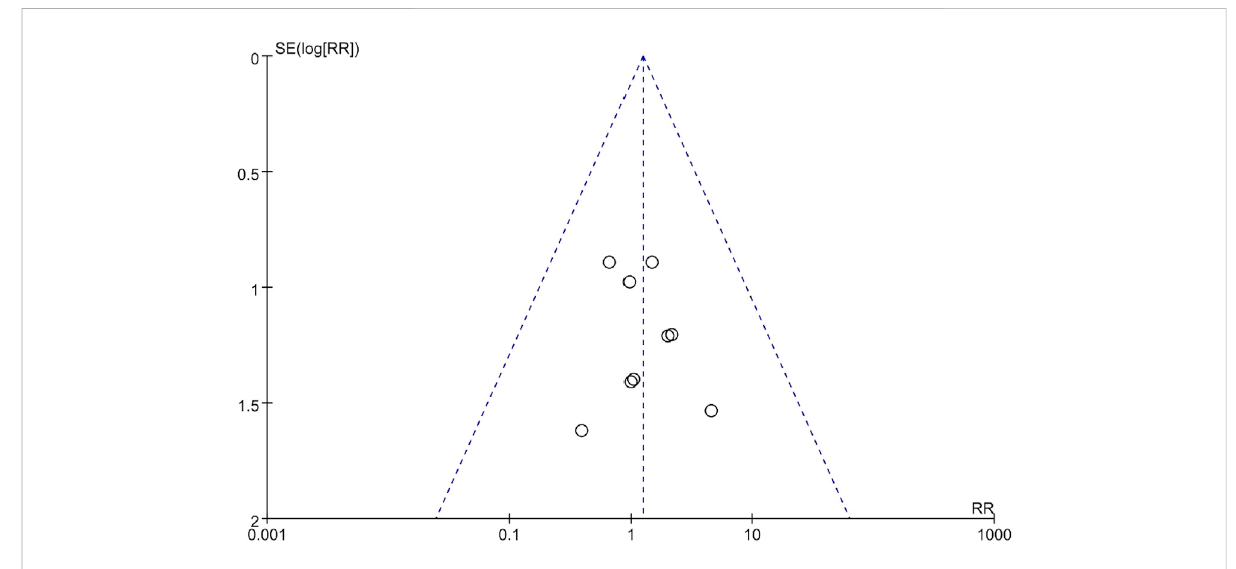
FIGURE 9 Funnel plot of the incidence of deep vein